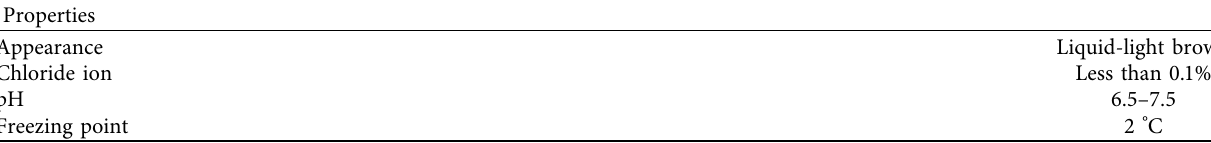
Table 3: Chemical properties of superplasticizer [46].